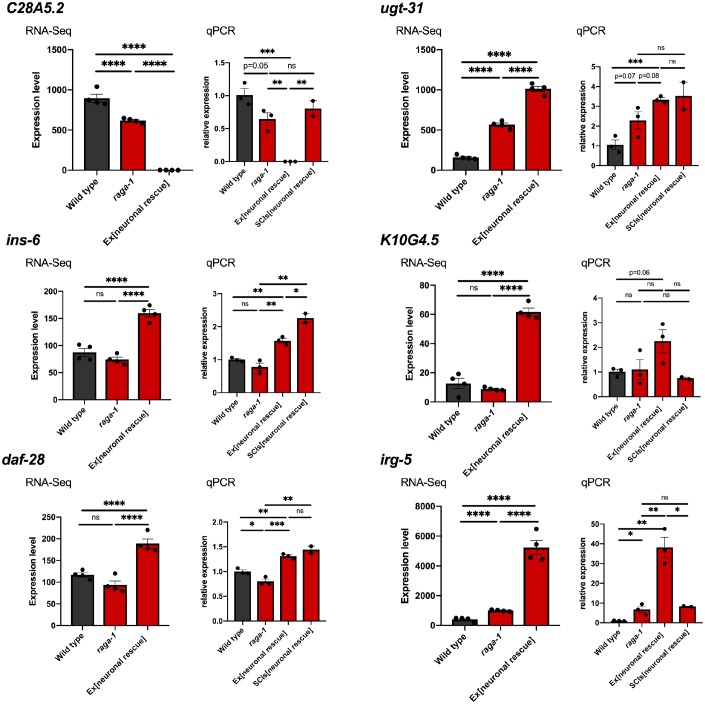
Validation of changes identified by RNA-seq in independent biological samples.Independent biological samples were collected and tested for gene expression changes identified by RNA-Seq by qPCR. Three new samples for each strain used in the RNA-Seq experiment (wild type (N2), raga-1(ok386), and neuronal rescue strain) as well as two samples from the single copy transgene neuronal rescue line were collected as L4 staged larvae, processed, tested, and analyzed in parallel. Genes selected for validation were among the most significantly changed genes in pairwise comparison between raga-1 and neuronal rescue. For each gene, the expression profile obtained by RNA-Seq is plotted to the left, and relative expression determined in new samples by qPCR is plotted to the right. The qPCR results for ins-6 and daf-28 shown in Figure 2e are shown again here for comparison to values obtained by RNA-Seq. Data are presented as mean ± s.e.m. P value: NS no significance, *<0.05, **<0.01, ***<0.001, ****<0.0001 relative to controls. Statistical significance for qPCR was determined by two-tail t-test. Significance values for RNA-Seq are corrected for false discovery rate. Source data are provided in Figure 3—figure supplement 2—source data 1.10.7554/eLife.49158.018Figure 3—figure supplement 2—source data 1.Figure 3—figure supplement 2 qPCR validation of RNA seq results.